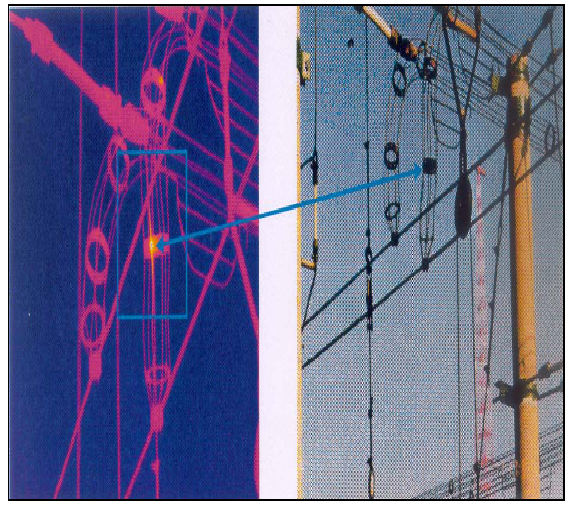
Fig 6. Thermogram of the junction feeder line – spacing